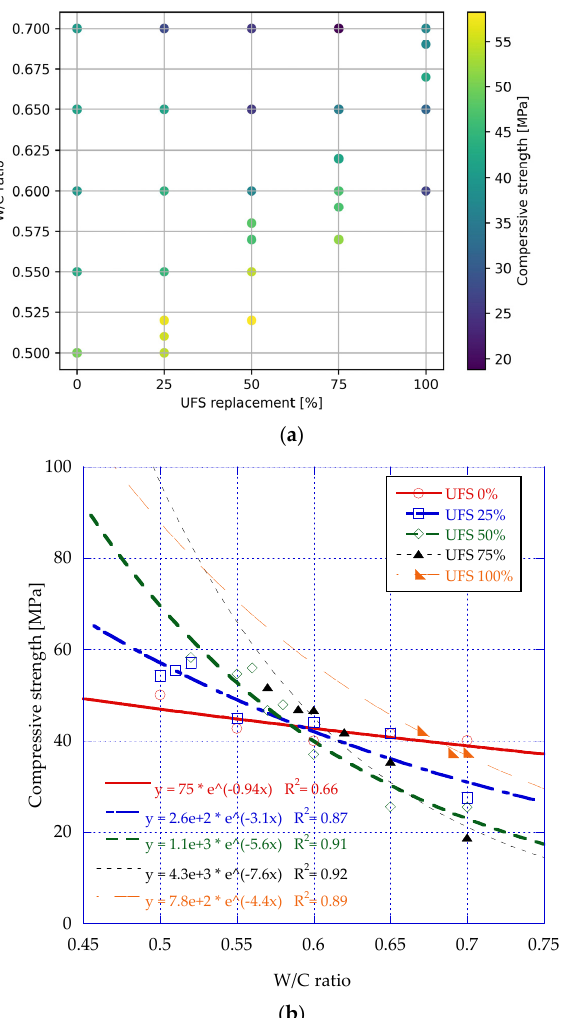
Figure 17. Compressive strength of mortars (MPa) ( a ) and W/C ratio influence on compressive strength of UFS mortars ( b ).